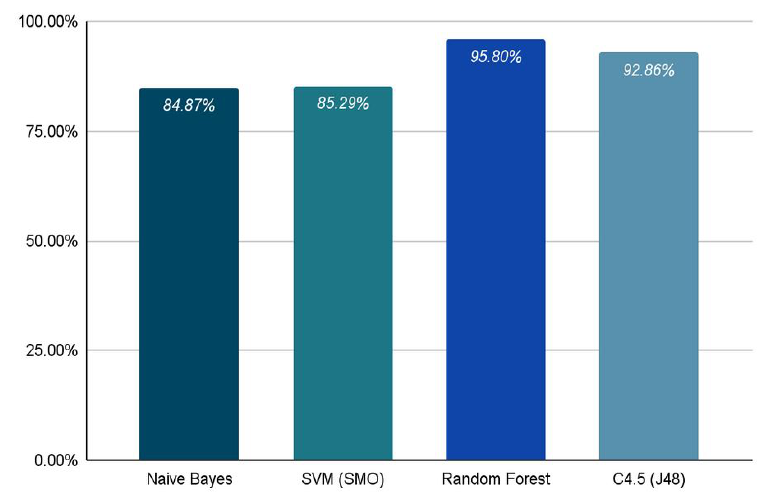
Figure 8. Comparison of the classification algorithms with the Netmate features and accuracy results.